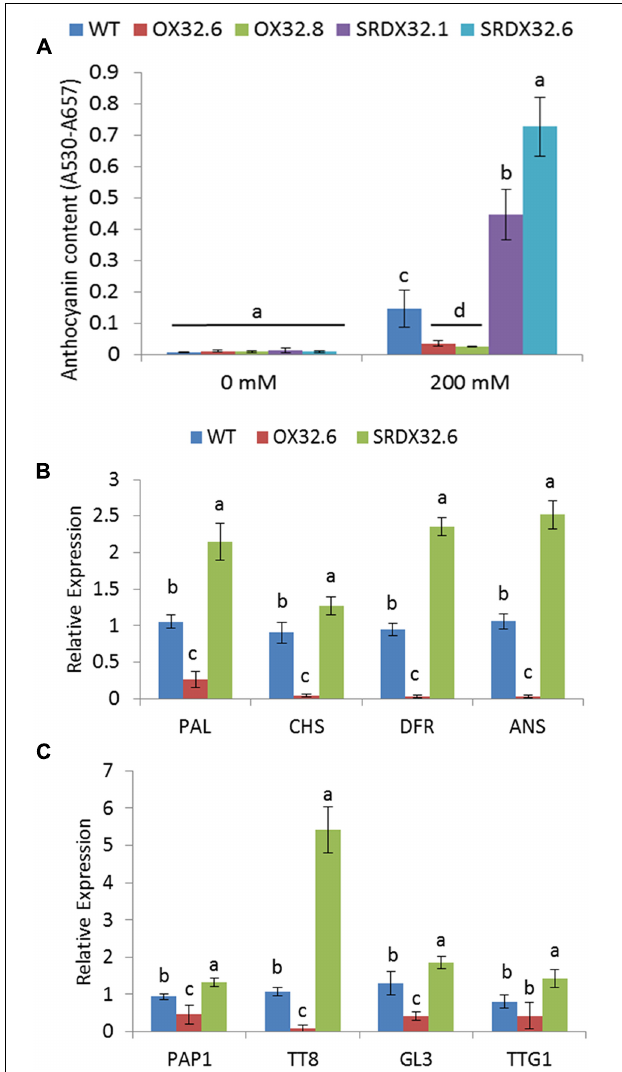
FIGURE 6 | Salinity-induced anthocyanin biosynthesis in ANAC032 transgenic lines. (A) Anthocyanin content in response to salinity stress. Three-week-old plants of WT and ANAC032 transgenic lines were treated with 200 mM NaCl for 2 weeks. Data represent values from three biological replicates ( ± SD). Bars with same letters are not significantly different from each other according to one way ANOVA LSD test ( P < 0.05). (B) qRT-PCR analysis of ABGs in leaves of plants subjected to salinity stress. (C) qRT-PCR analysis of transcription factors that positively regulate the expression of ABGs plants subjected to salinity stress. ACT7 was used as internal control. For each gene, bars with same letters are not significantly different from each other according to one way ANOVA LSD test ( P <